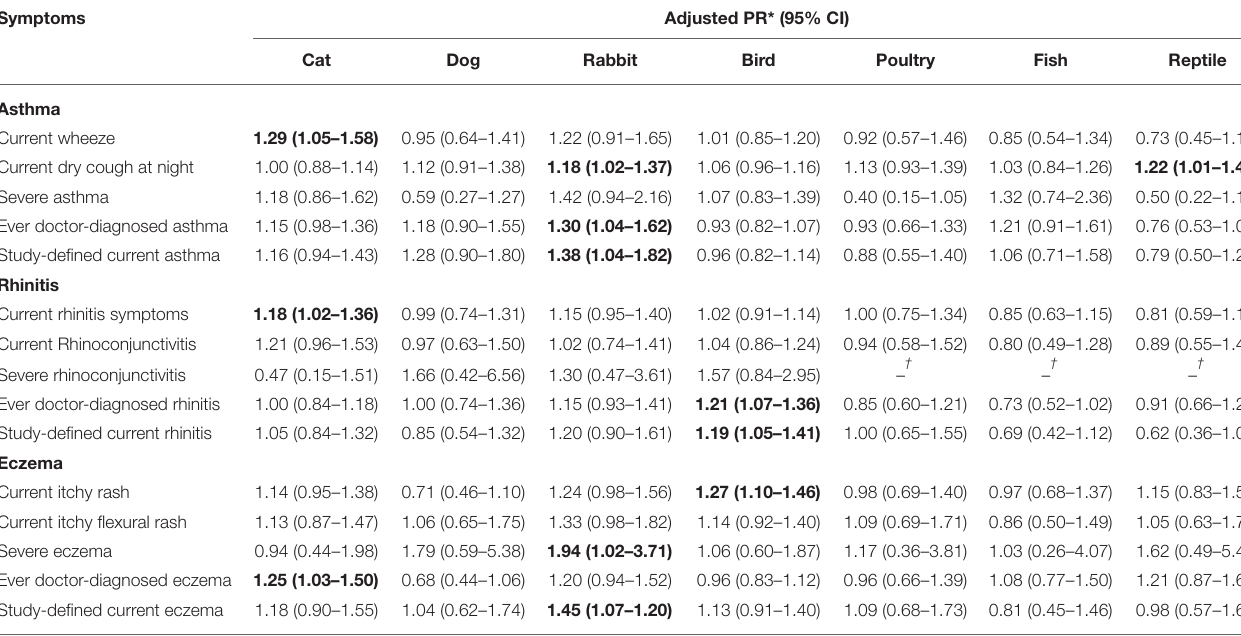
TABLE 4 | Associations between pet type/group and asthma, rhinitis, and eczema symptoms.